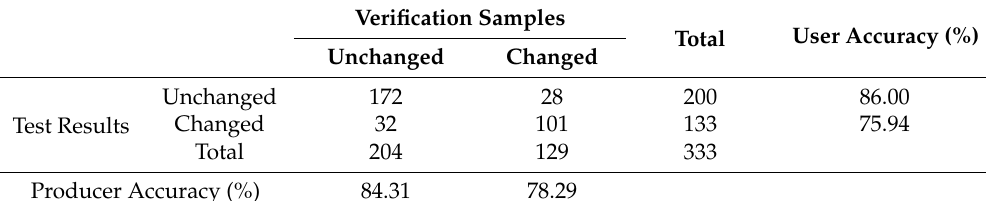
Table 7. Confusion matrix of SCCD.